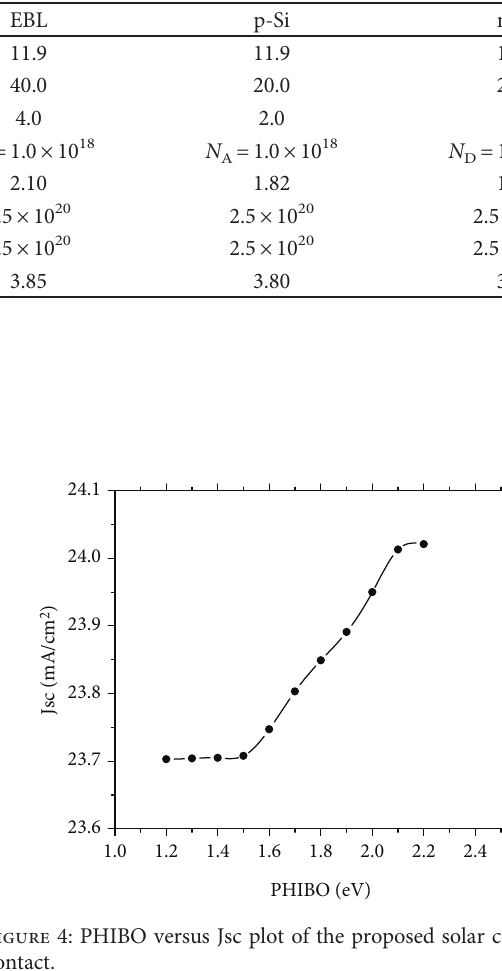
Table 4: Di ff erent layers of electronic properties used in the APMS simulation.